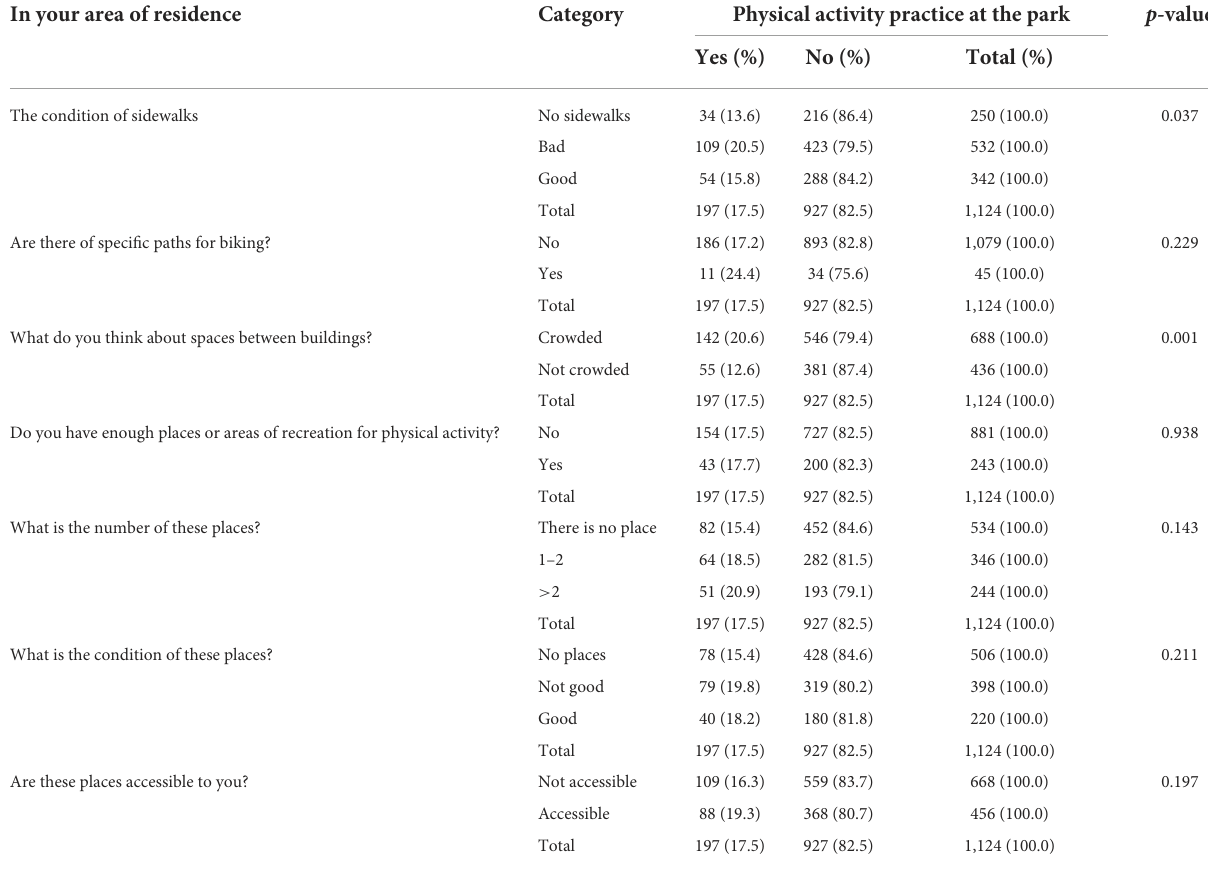
TABLE 6 Distribution of perceptions about built environment by physical activity at the park among study participants ( N =